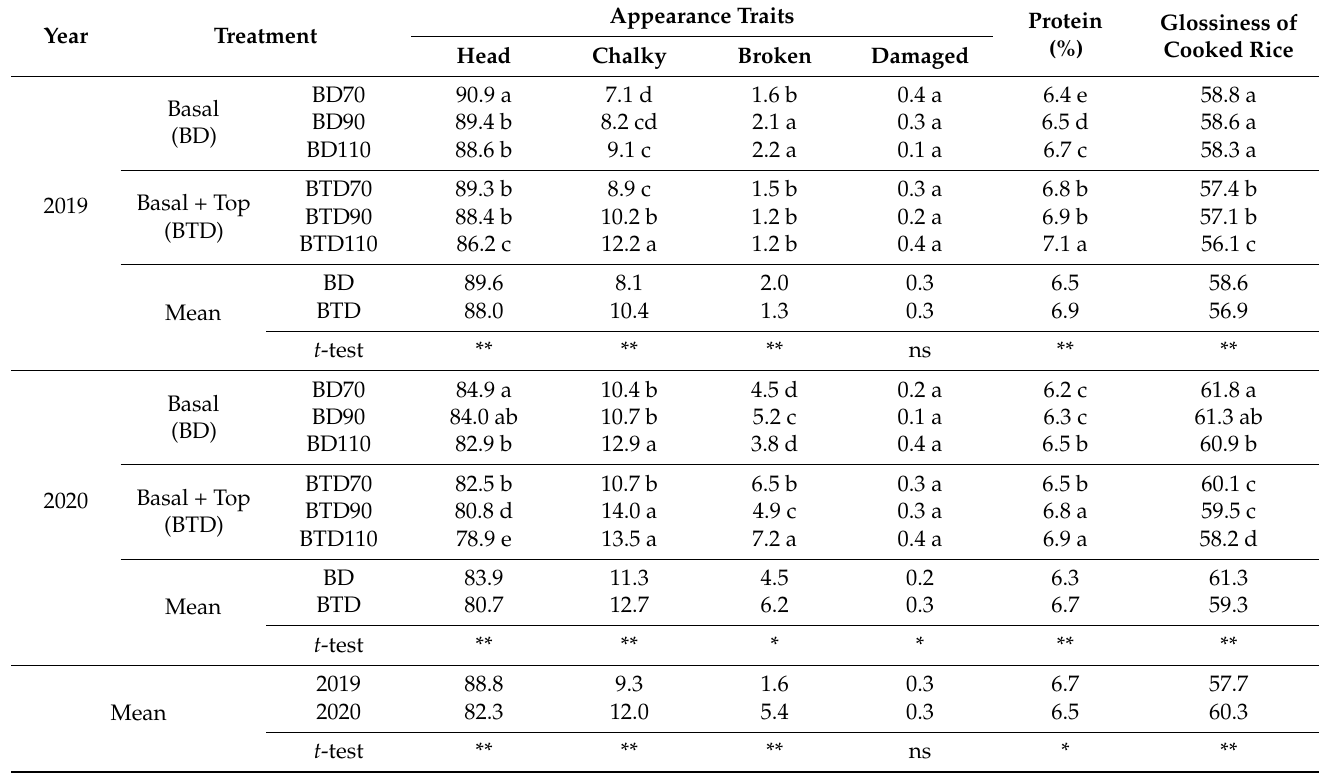
Table 5. Grain quality traits according to nitrogen application